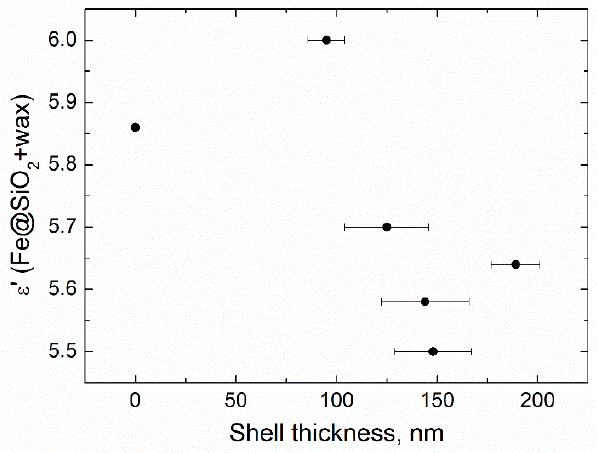
Figure 13. Quasi-static permittivity vs. thickness of the dielectric shell deposited at different durations of hydrolysis.